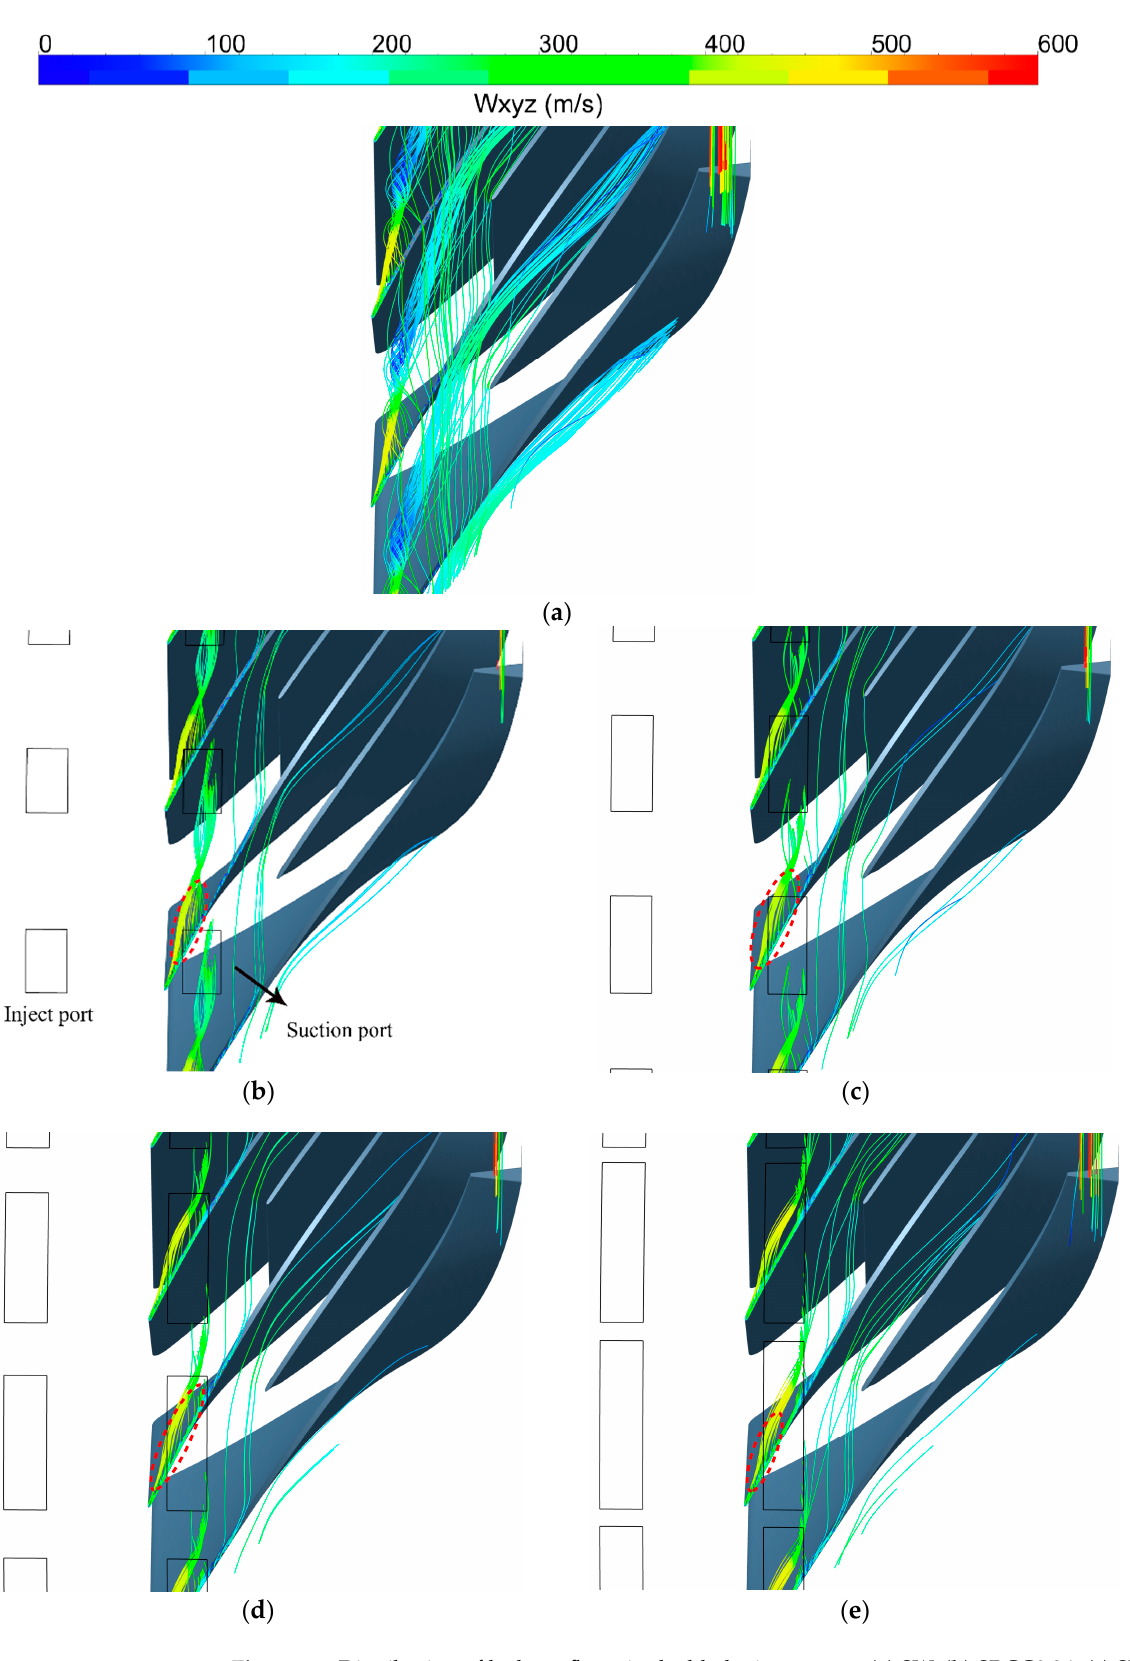
Figure 16. Distribution of leakage flows in the blade tip passage. ( a ) SW. ( b ) SRCC0.36. ( c ) SRCC0.54. ( d ) SRCC0.72. ( e ) SRCC0.9.